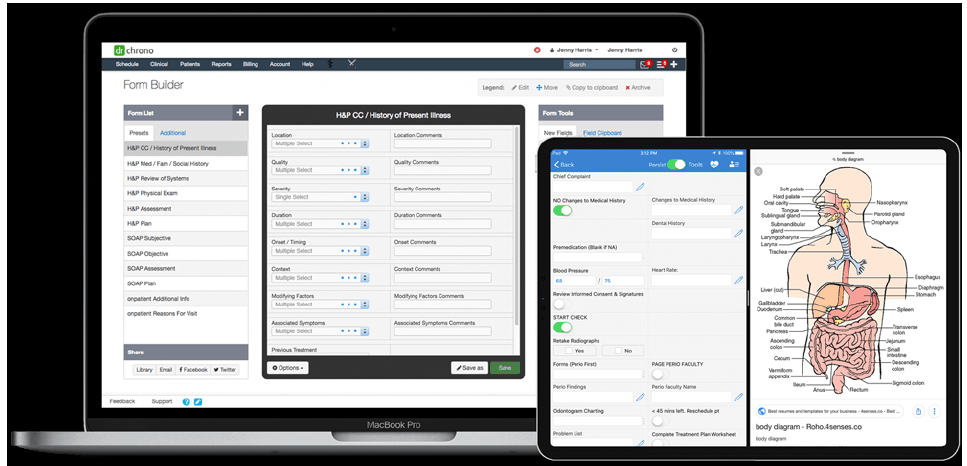
Figure 1. Electronic health record in mobile device [35].